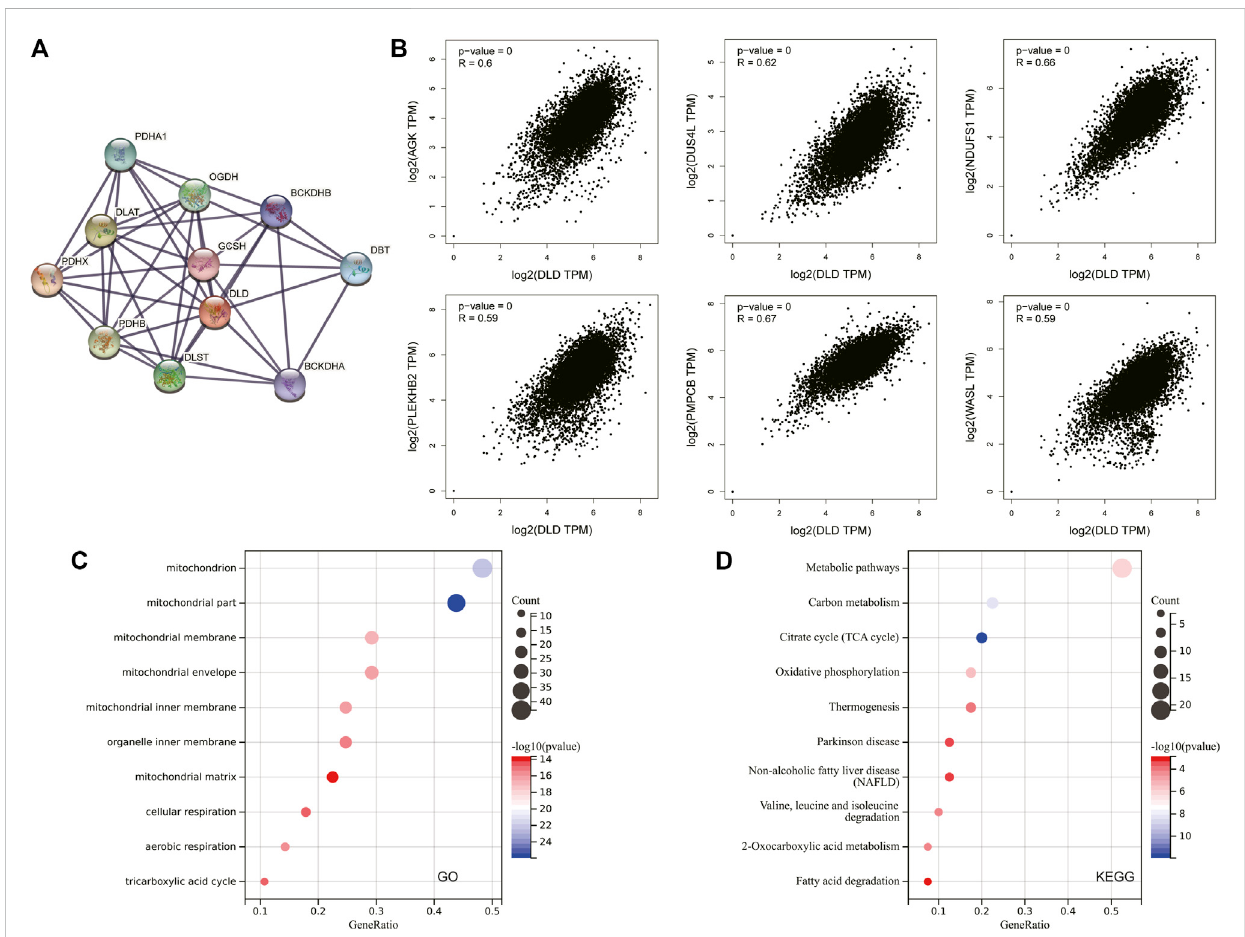
FIGURE 12 DLD-related gene enrichment analysis. (A) The DLD-interacting molecular network generated with the STRING tool. (B) Correlation scatterplot of thetop6genesassociatedwithDLDobtainedwiththeGEPIA2.0tool. (C) GOenrichmentanalysisofDLD-relatedgenes. (D) KEGGenrichmentanalysisof DLD-related